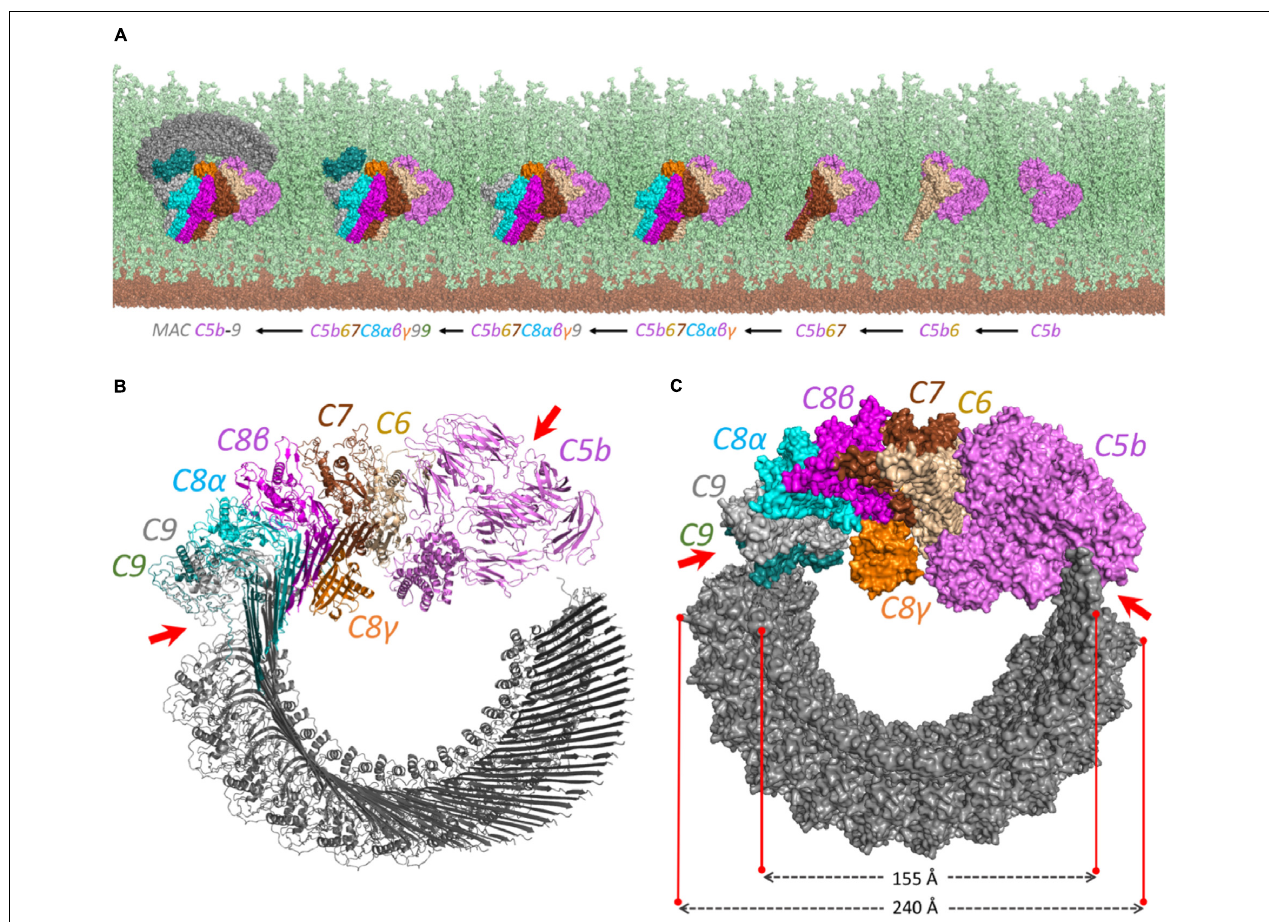
FIGURE 3 | The proposed structural model for the MAC complex. (A) The MAC C5b–9 complex formation on the surface of Gram-positive bacteria. It represents how the complement proteins are added one by one and interact together to constitute the MAC complex. The view is from above to show the complete pore formation on the top of the peptidoglycan surface. The cell membrane and peptidoglycan layer are shown in brown and light green, respectively. (B) The cartoon view of each component shows how the interaction between C5b and C8 initiates the multiple binding of C9 to form the pore. (C) The surface representation. The diagonal length of the inside and the outside of the pore is around 15.5 and 24 nm, respectively. The irregular patterns in C5b–C6 and C9–C9 interactions are shown by red arrows on both (B) and (C) panels.